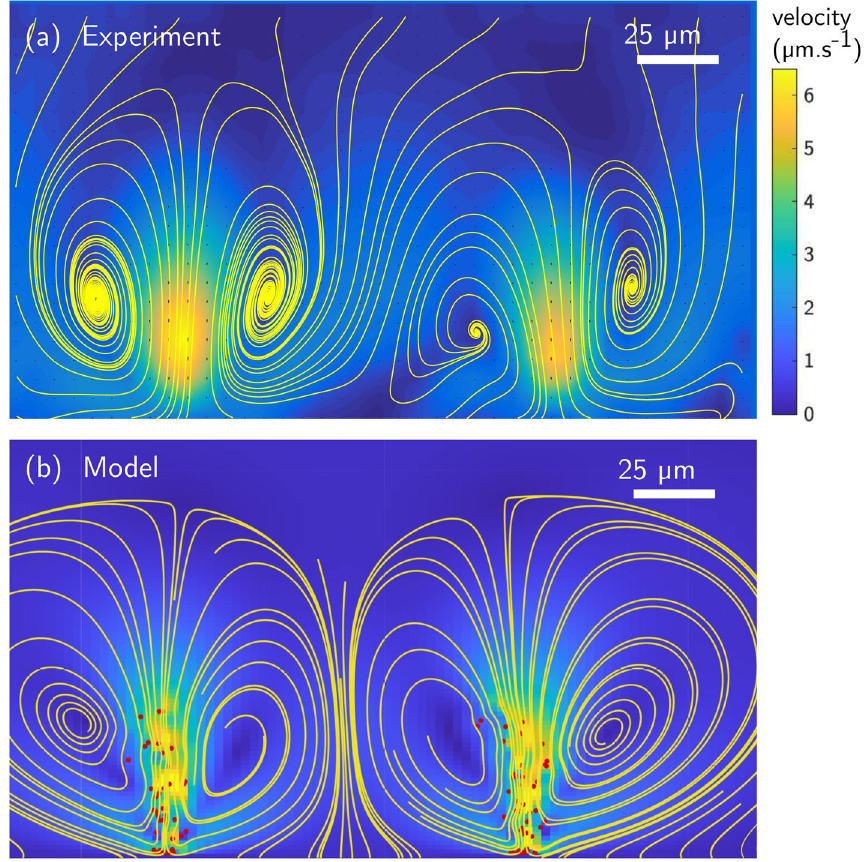
Figure 3. Convection cells created by two plumes in a 200 µ m glass capillary. ( a ) Experimental measurements showing magnitude (colormap) and streamlines of the flow field averaged over one minute. ( b ) Convection cells and flow obtained with the theoretical model, with red dots representing the instantaneous location of the